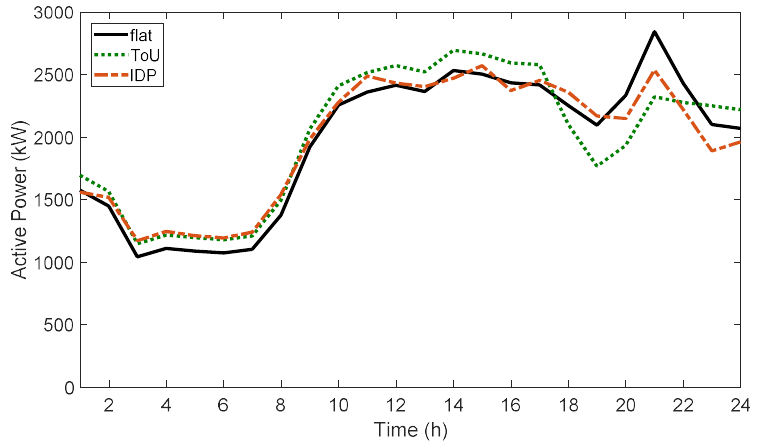
Figure 7. The impact of DR programs on total load profile.